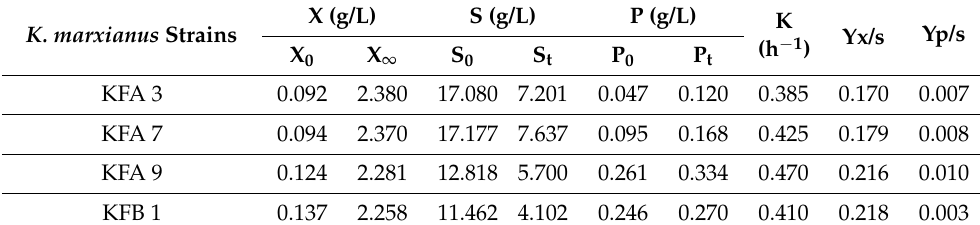
Table 3. Fermentation kinetics of K. marxianus strains. K. marxianus